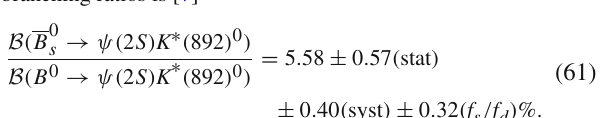
longitudinal polarization fraction is approximately 43%, whereas in the ψ( 1 D ) mode,itisabout10%,withparallelandverticalfractions being approximately equal in both modes. For the D-wave ψ( 2 S ) decay mode, the three polarization fractions are roughly at the same level of approximately 33%, but they are distinctly different in the